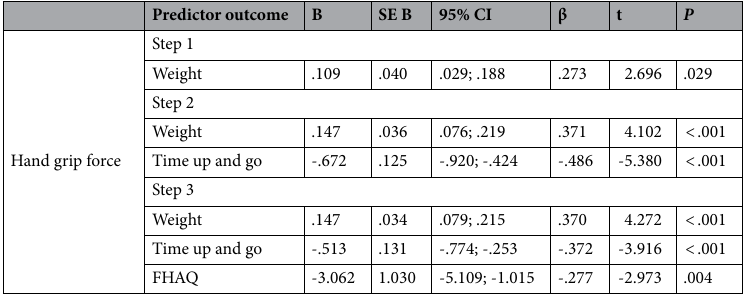
Table 3. Summary of the stepwise regression analyses to determine predictors of hand grip force. FHAQ, Fibromyalgia Health Assessment Questionnaire. R 2 adj. = .064 for step 1, R 2 adj. = .286 for step 2, R 2 adj. = .344 for step